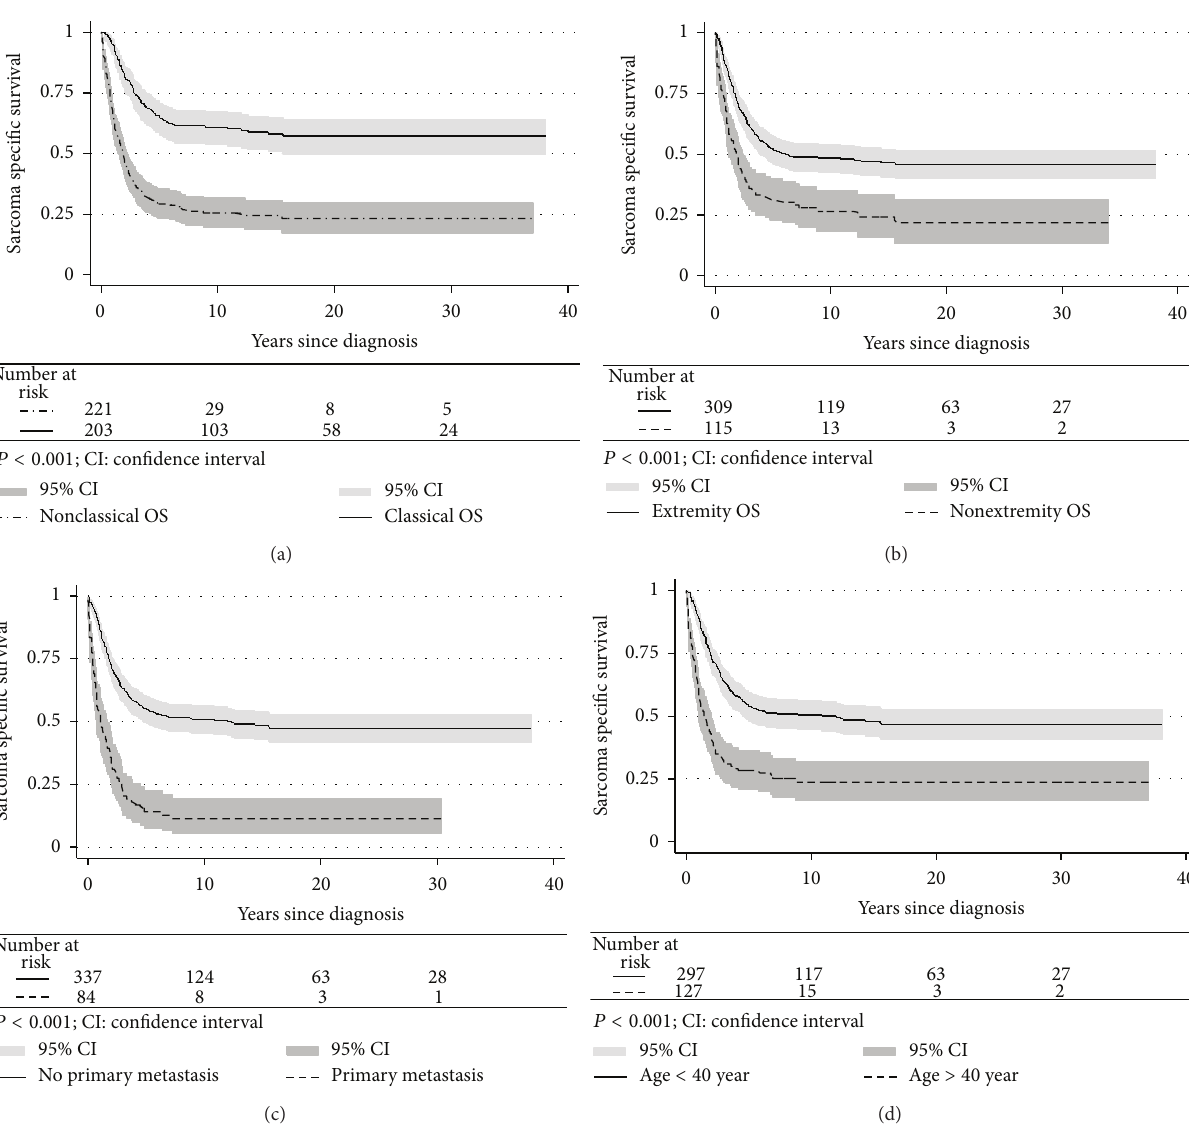
Figure 3: Sarcoma specific survival of classical versus nonclassical osteosarcoma (OS) patients (a). Extremity versus nonextremity OS (b). Patients with and without metastasis at time of diagnosis (c). Patients above and below 40 years of age at time of diagnosis